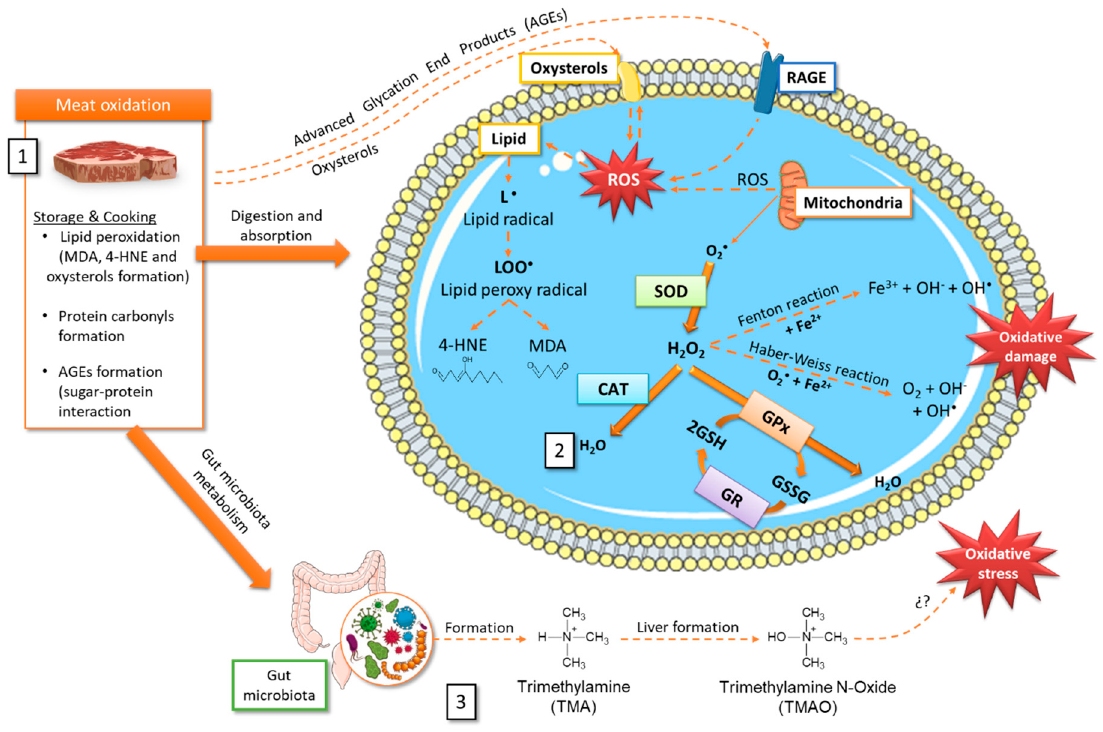
Figure 2. Tentative scheme relating storage and cooking oxidative processes in meat and the production / elimination of radical oxygen species (ROS). It is detailed (1) Oxidized compounds that can be generated in meat during storage and cooking. (2) Some intracellular mechanisms involved in ROS formation, oxidative damage, and possible elimination through the antioxidant machinery. (3) TMAO formation after choline and L-carnitine metabolism by the gut microbiota and subsequent oxidation in the liver. 4-HNE, 4-hydroxy-nonenal; AGEs, advanced glycation end-products; CAT, catalase; GPx, glutathione peroxidase; GR, glutathione reductase; GSH, reduced glutathione; GSSG, oxidized glutathione; H 2 O 2 , hydrogen peroxide; LOO • , lipid peroxyl radical; MDA, malondialdehyde; RAGE, receptor for AGEs- advanced glycation end-products; ROS, radical oxygen species; SOD, superoxide dismutase; TMA, trimethylamine; TMAO, trimethylamine N-Oxide.